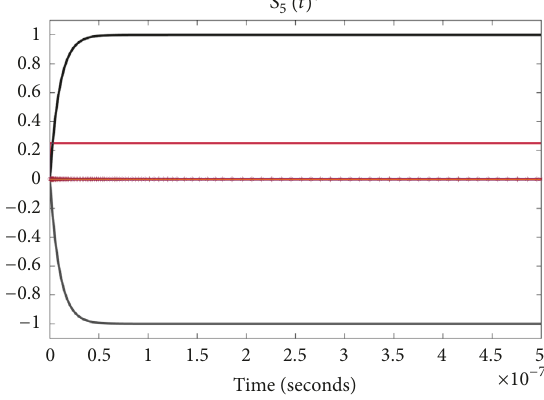
Figure 11: Trajectories of elements of the matrix 𝑆 5 (𝑡) †